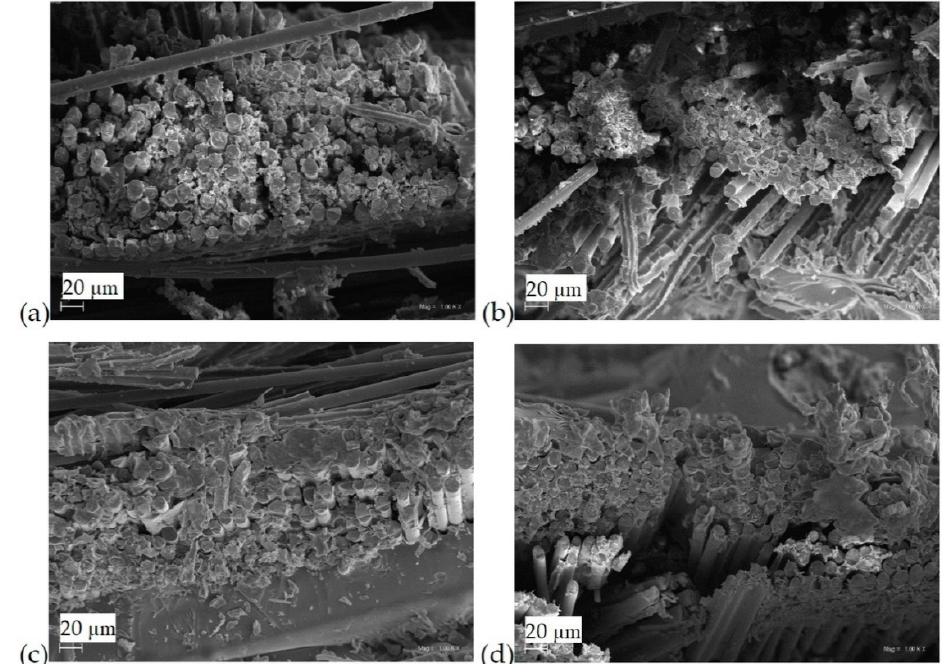
Figure 1. Structure of composites ( a ) 0PVC; ( b ) 2.5PVC; ( c ) 5PVC; ( d ) 10PVC.